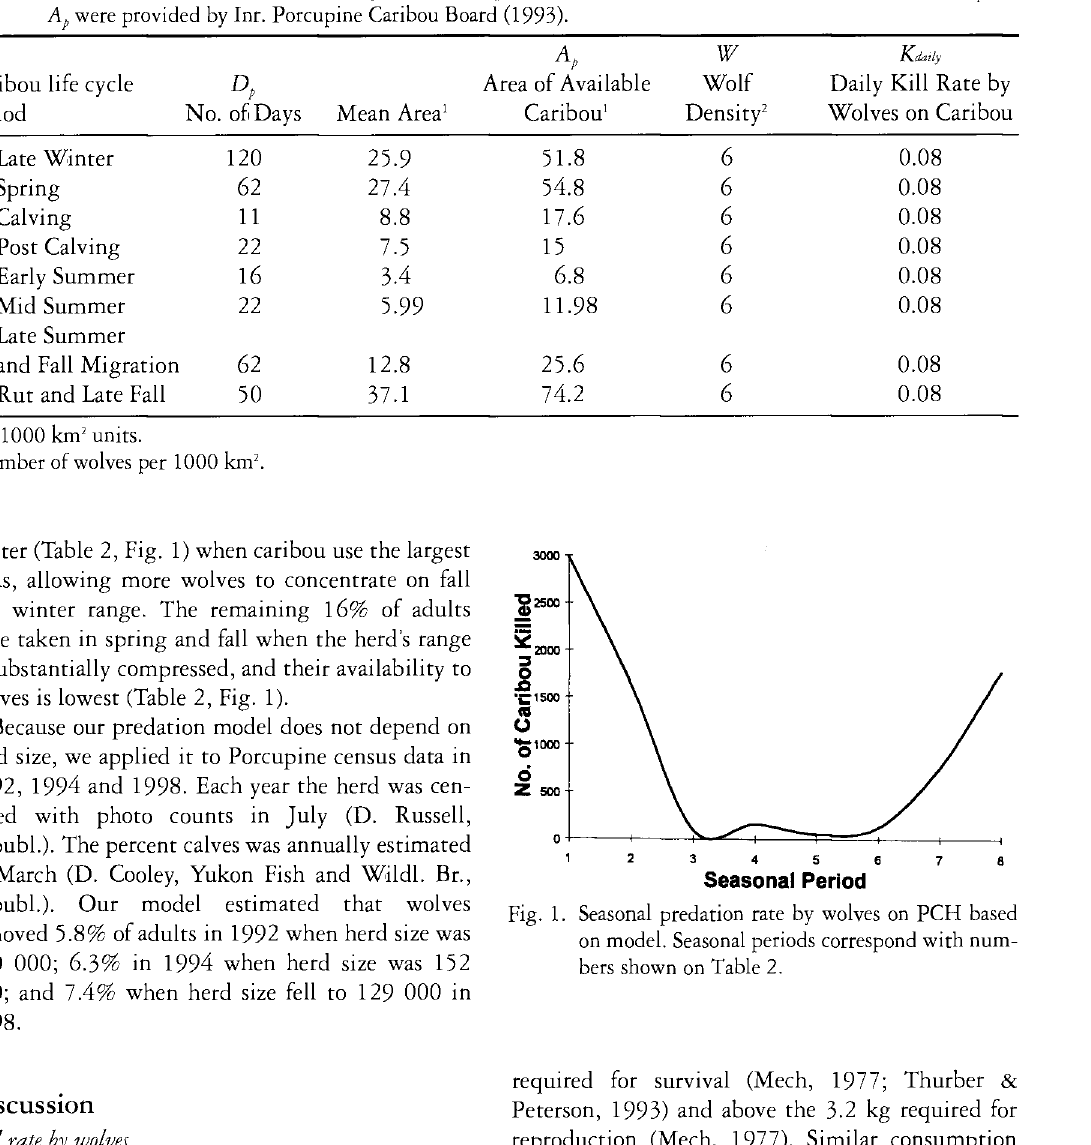
Table 2. Variables and values used in modeling annual wolf predation rare on Porcupine caribou herd. Values for D ; ,and A p -were provided by Inr. Porcupine Caribou Board (1993).